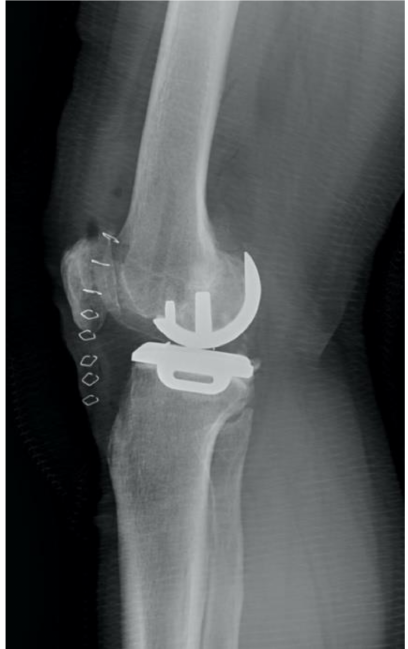
Figure 3. A postoperative image of the femoral component overhang over 4 mm.